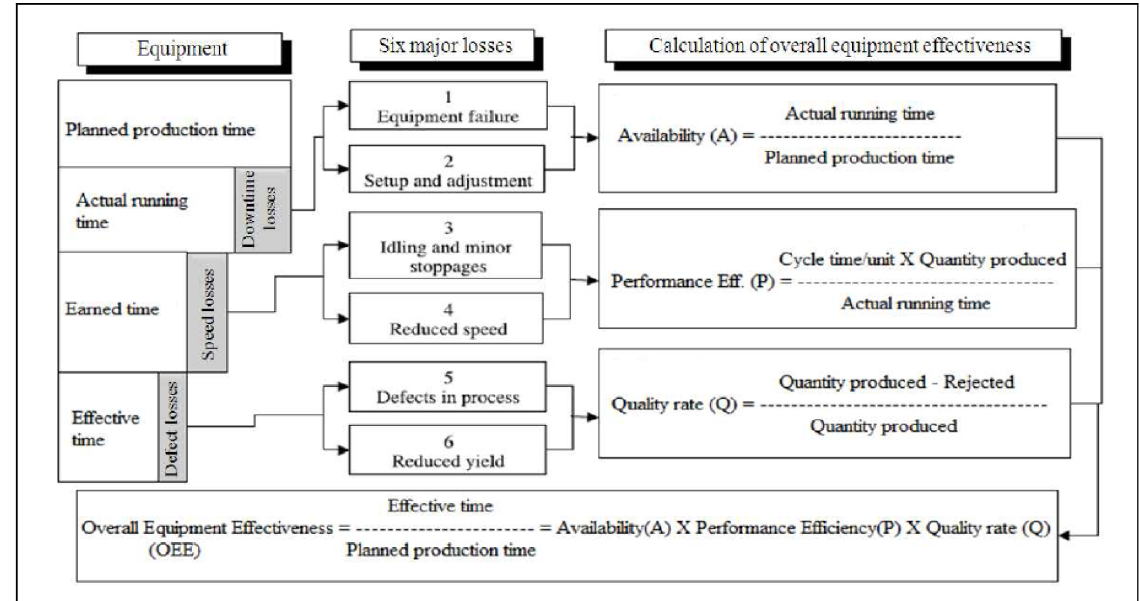
Figure 1. Six big losses and calculation of OEE (Eswaramurthi & Mohanram,